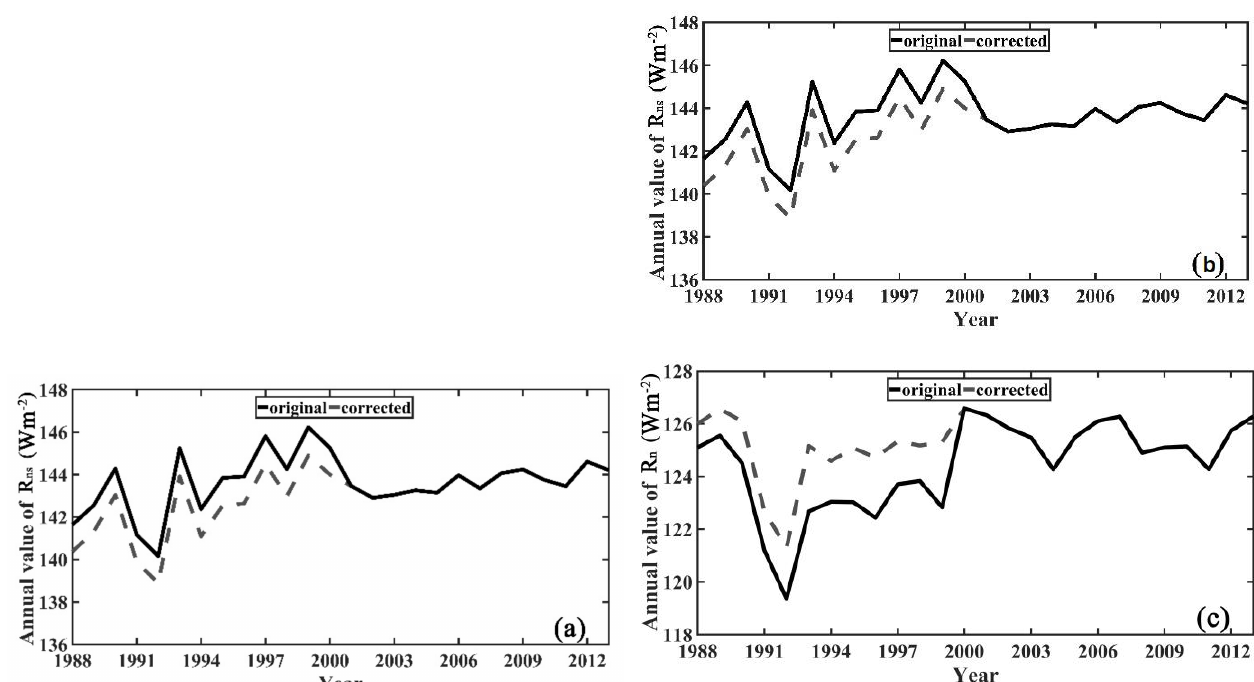
Figure 10. Interannual variations in the annual mean sea-surface ( a ) R ns , ( b ) R li , and ( c ) R n from 1988 to 2013, from the original and corrected J-OFURO3 over global ice-free oceans.